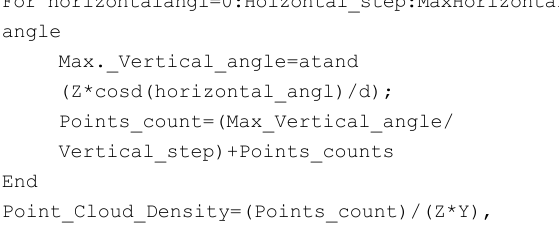
Figure 4. Scanning positions to fully cover the façade